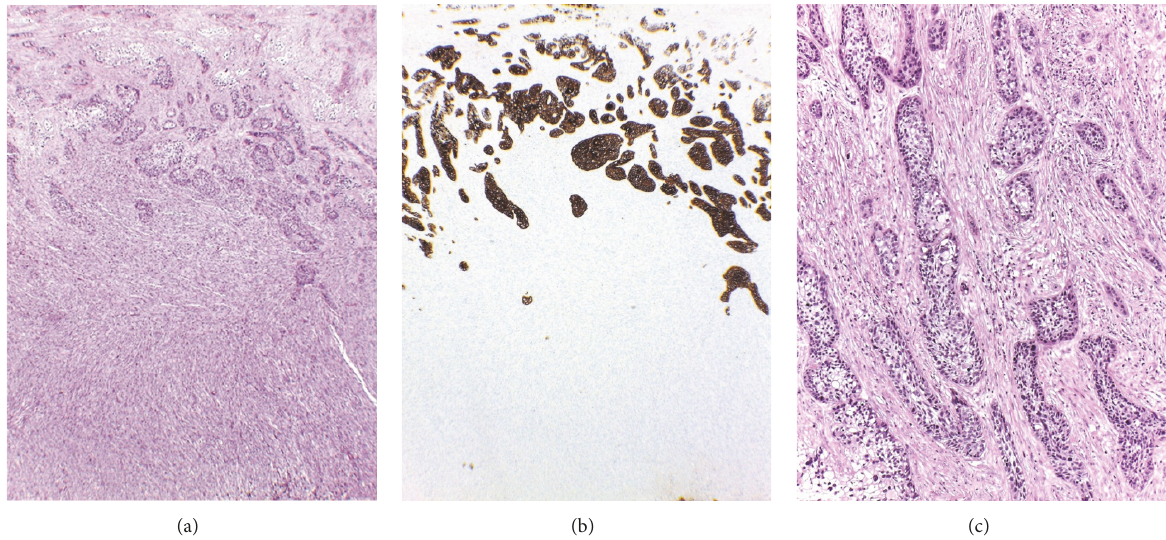
Figure 2: Leiomyosarcoma and squamous cell carcinoma. (a) Squamous cell carcinoma at the upper part of leiomyosarcoma. Note an abrupt demarcation between two components (H&E, 4x). (b) Squamous cell carcinoma was highlighted by positive staining for AE1/AE3, whereas leiomyosarcoma was completely negative (IHC stain, 4x). (c) Infiltrative nests of squamous cell carcinoma surrounded by desmoplastic stromal reaction (H&E,